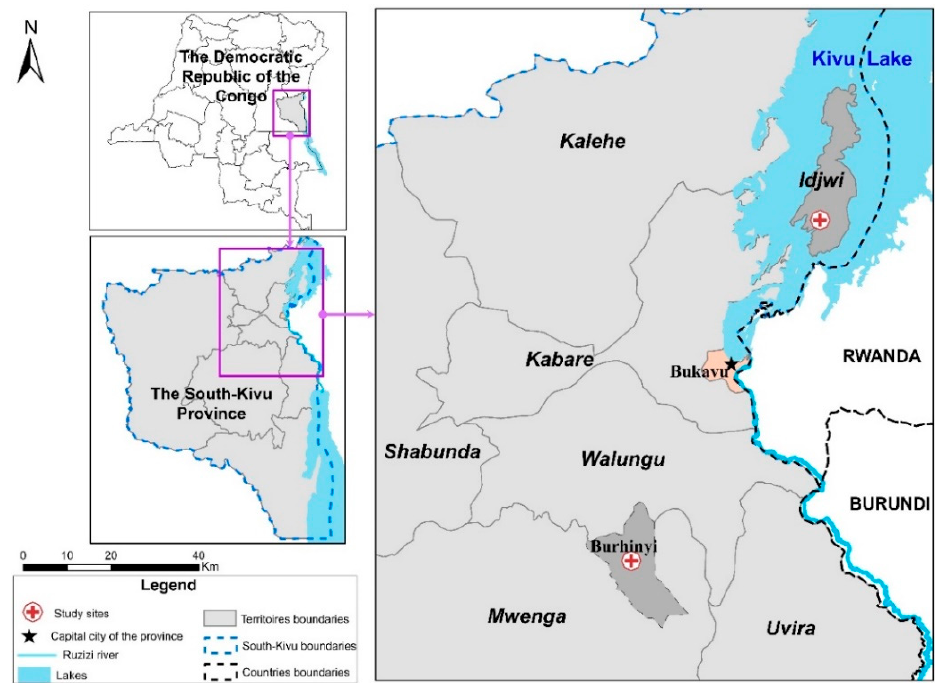
Figure 1. Map of the study area.